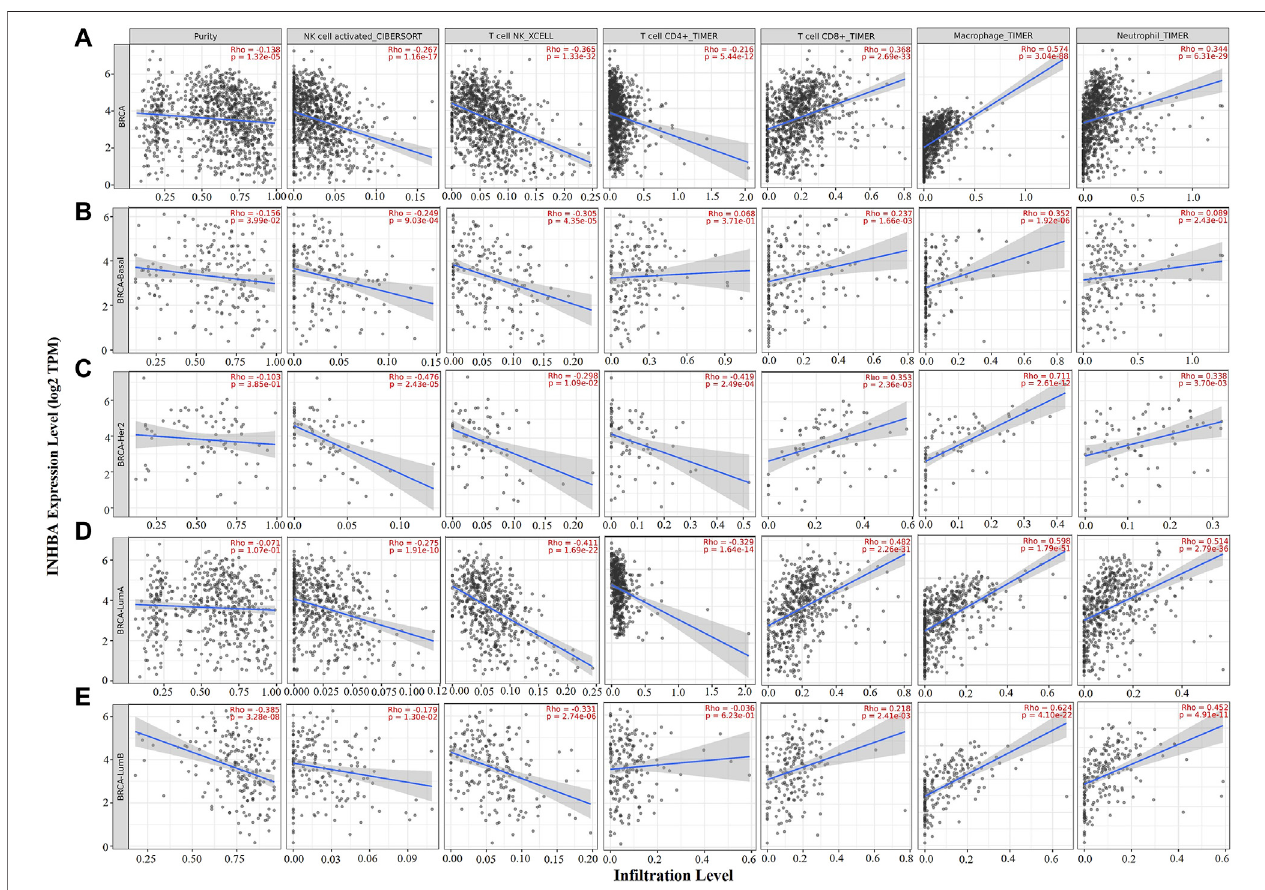
FIGURE 4 | Correlation of INHBA expression with immune in fi ltration level in BRCA (breast invasive carcinoma) and subtypes (BRCA-Basal, BRCA-Her2, BRCA- LumA, and BRCA-LumB) analyzed by TIMER2.0. (A,C,D) INHBA expression was signi fi cantly negatively related to activated NK, NKT, and CD4 + T cell in fi ltrating levels and had signi fi cantly positive correlations with in fi ltrating levels of CD8 + T cells, macrophages, and neutrophils in BRCA ( n = 1,100), BRCA-Her2 ( n = 82), and BRCA- LumA ( n = 568). (B) INHBA expression was signi fi cantly negatively related to activated NK and NKT cell in fi ltrating levels and had signi fi cantly positive correlations with in fi ltrating levels of CD8 + T cells and macrophages in BRCA-Basal ( n = 191). (E) INHBA expression was signi fi cantly negatively related to activated NK and NKT cell in fi ltrating levels and had signi fi cant positive correlations with in fi ltrating levels of CD8 + T cells, macrophages, and neutrophils in BRCA-LumB ( n = 219).